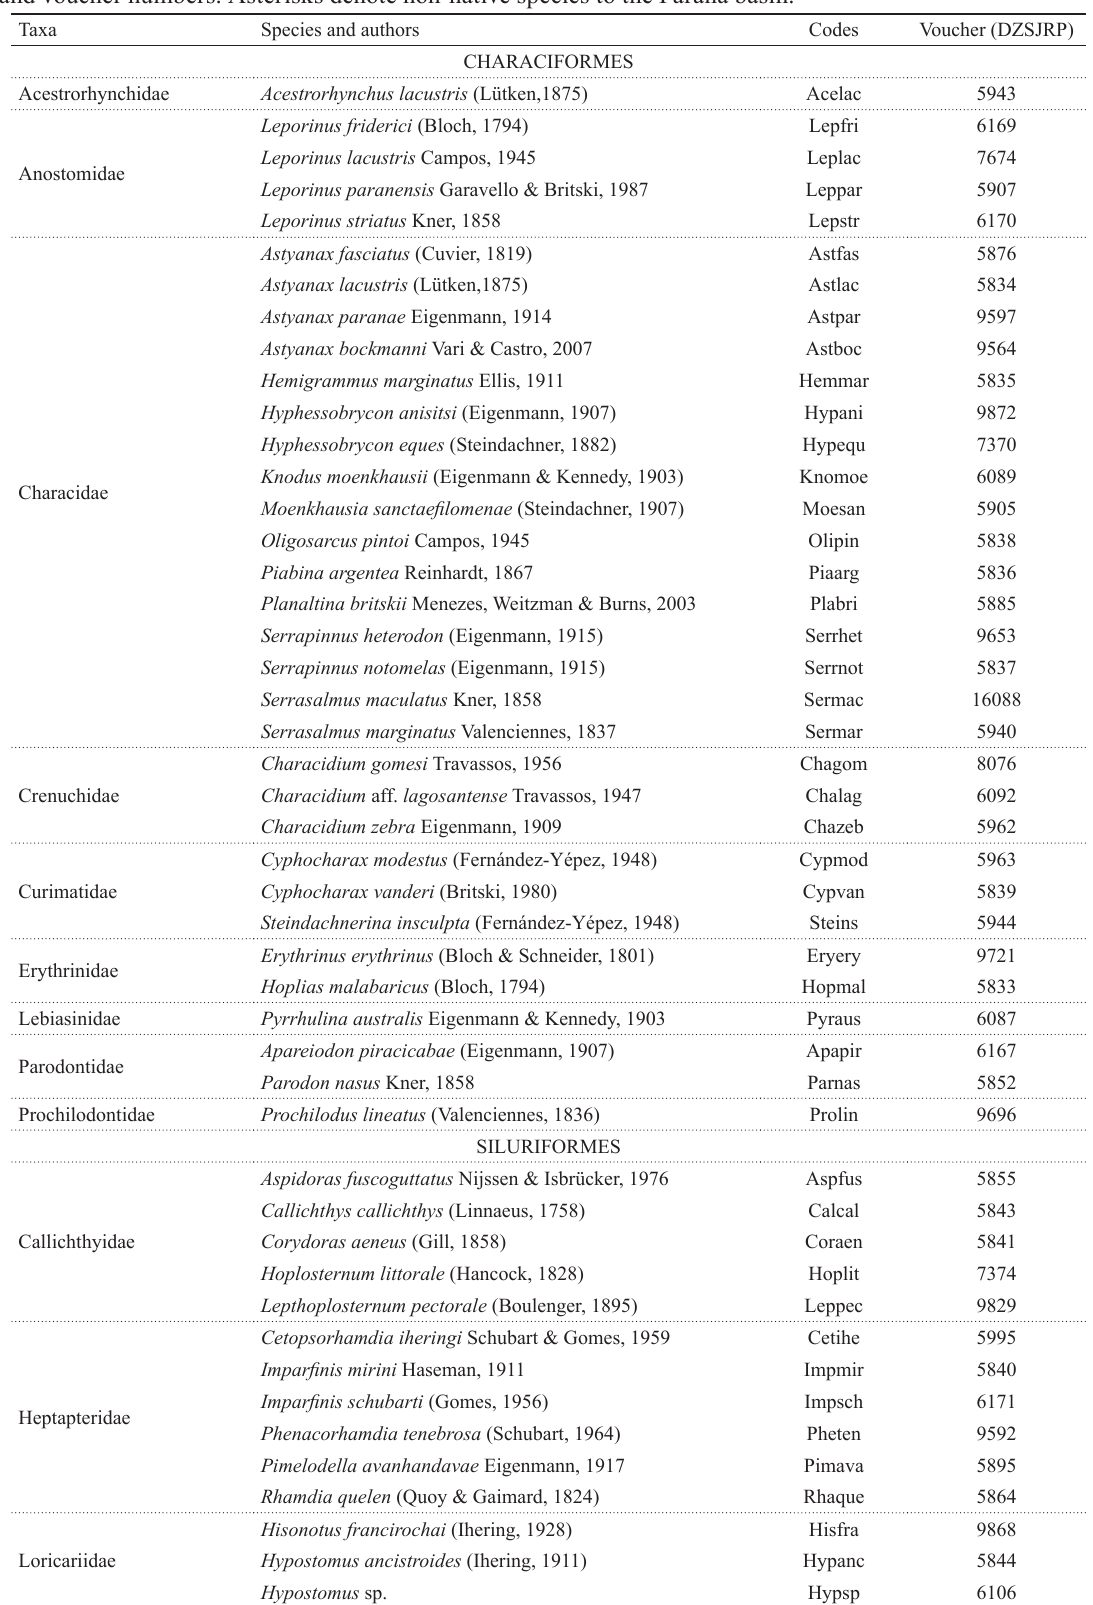
Table 2. Species registered in the 91 streams, listed according the taxonomic classification of Buckup et al . (2007), their codes, and voucher numbers. Asterisks denote non-native species to the Paraná